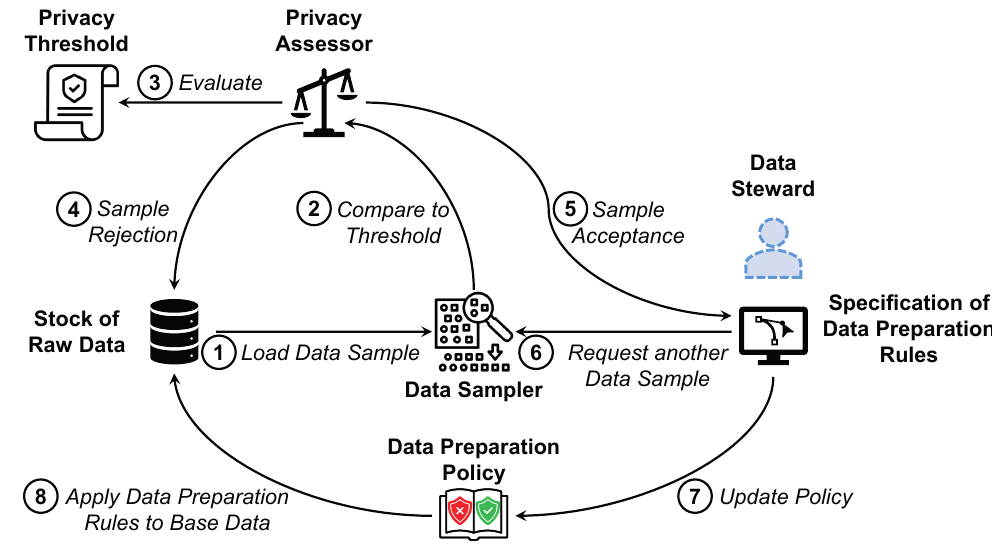
Figure 3. Workflow of the sample-based approach for data preparation applied in SMARTEN. (cid:192) Initially, the data sampler picks a representative data sample from the stock of raw data. Descriptive analyses are performed on the base data to identify data items that